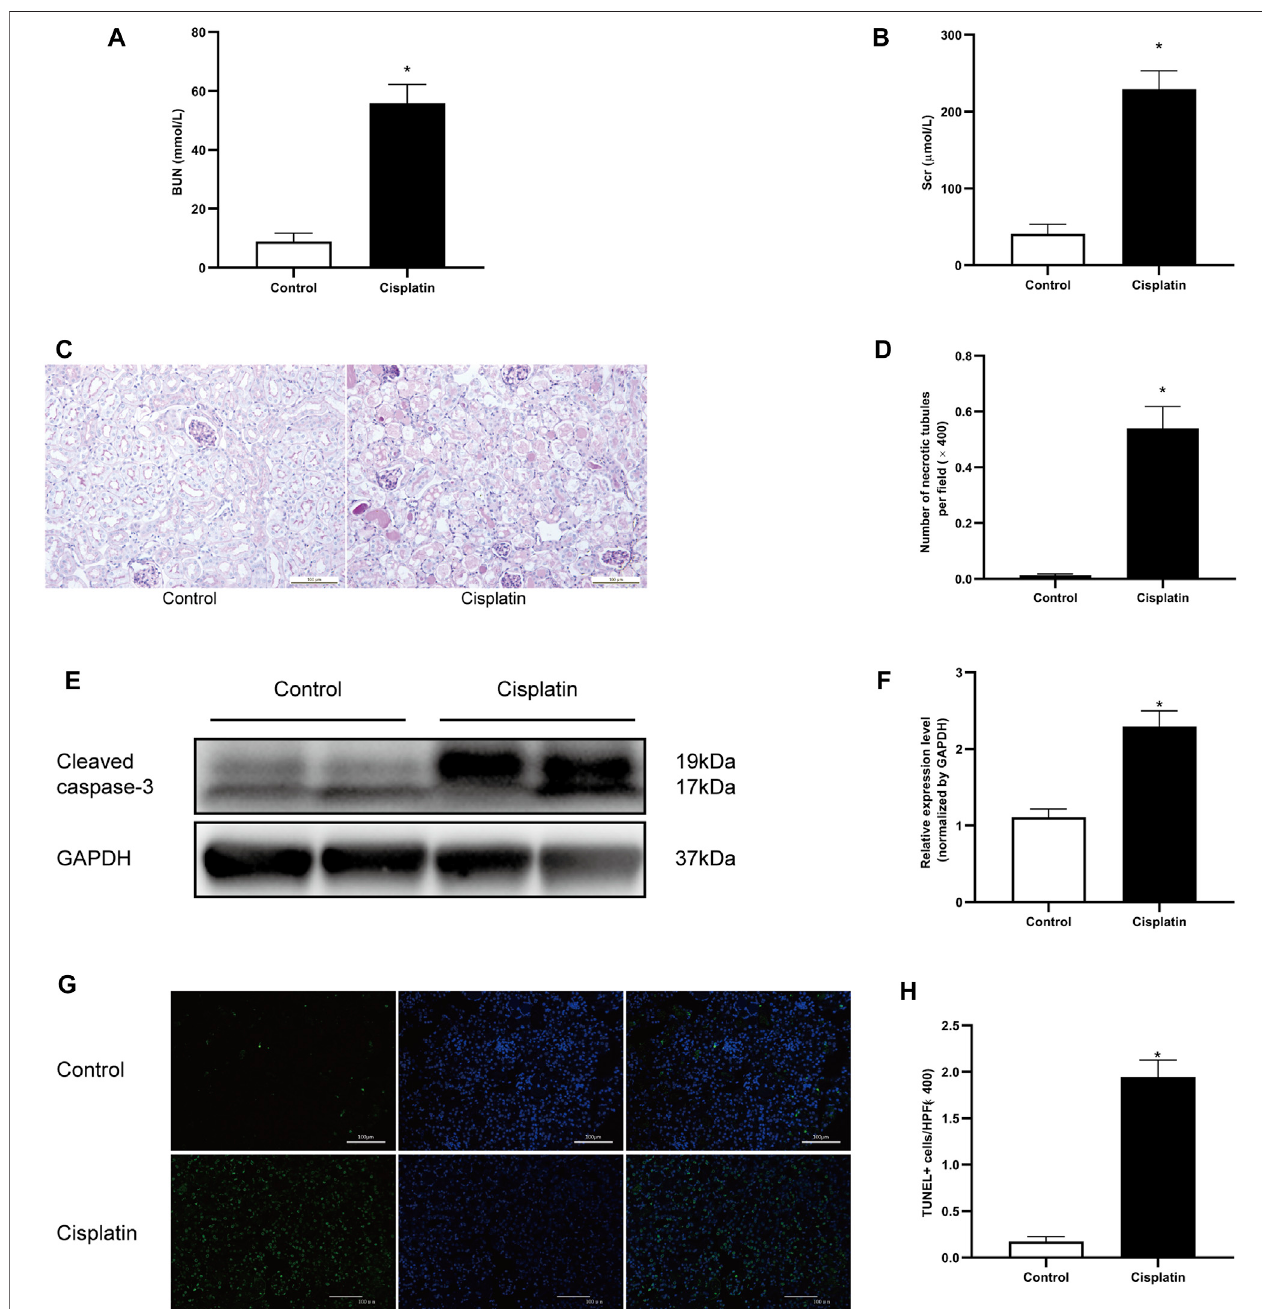
FIGURE 1 | Cisplatin-induced AKI in mice. 129 male mice were treated with vehicle or cisplatin (20 mg/kg, intraperitoneal) and sacri fi ced on day 3 after cisplatin injection. (A) The histogram showing the level of blood urea nitrogen (BUN) in each group. * p < 0.05 vs. control group, n (cid:1) 4 per group. (B) The histogram showing the levelofcreatinineineachgroup.* p < 0.05vs.controlgroup, n (cid:1) 4pergroup. (C) Periodicacid – Schiff(PAS)stainingshowingthehistopathologicchangesinthekidneys. Original magni fi cation × 200; bar (cid:1) 100 μ m. (D) The histogram showing the number of necrotic tubules in the kidneys. Data are the mean ± SD of 20 random fi elds obtained in each kidney slice. * p < 0.05 vs. control group, n (cid:1) 4per group. (E) Representative immunostaining images showing cleaved caspase-3 expression in kidney tissues. GAPDH was used as a loading control for normalizing changes in speci fi c gene expressions. (F) The histogram showing the level of cleaved caspase-3 protein expression that was calculated by densitometric analysis. * p < 0.05 vs. control group, n (cid:1) 4 per group. (G) Representative micrographs showing the terminal deoxynucleotidyltransferasedUTPnickendlabeling(TUNEL)stainingamongdifferentgroups.Originalmagni fi cation × 200;bar (cid:1) 100 μ m;green:TUNEL;blue:DAPI. (H) Quantitative analysis of TUNEL staining positive cells among different groups. Data are the mean ± SEM of 20 random fi elds obtained in each kidney slice. * p < 0.05 vs. control group, n (cid:1) 4 per group.